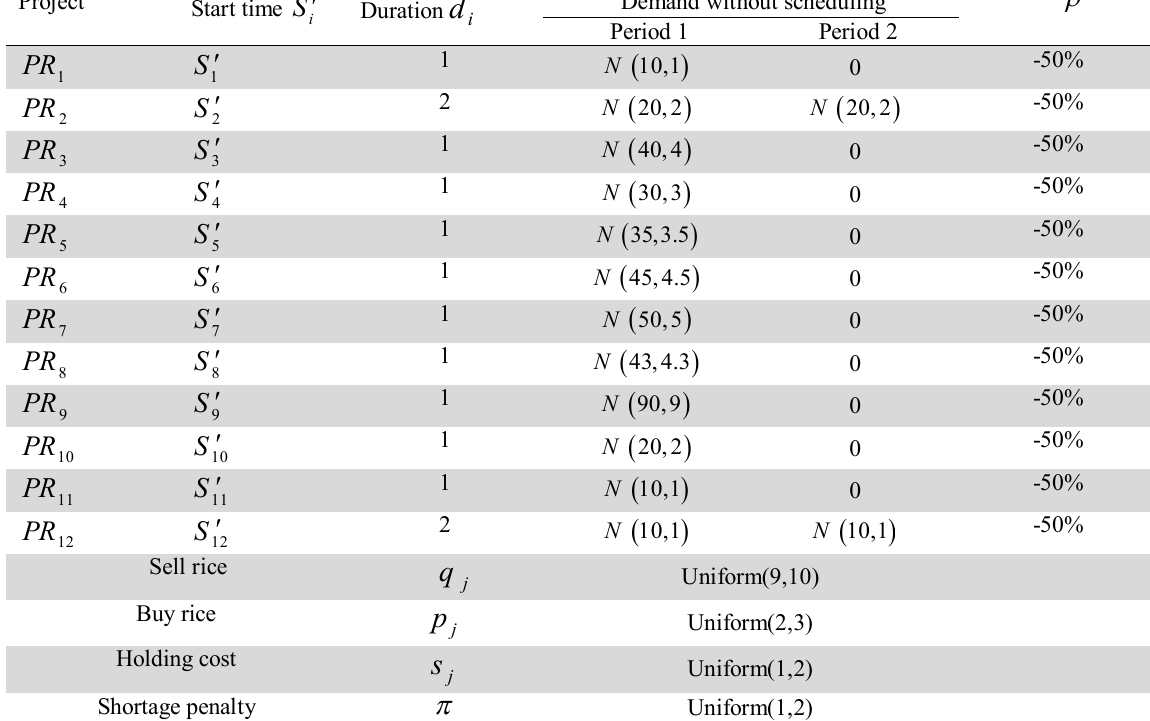
Specifications of the numerical example